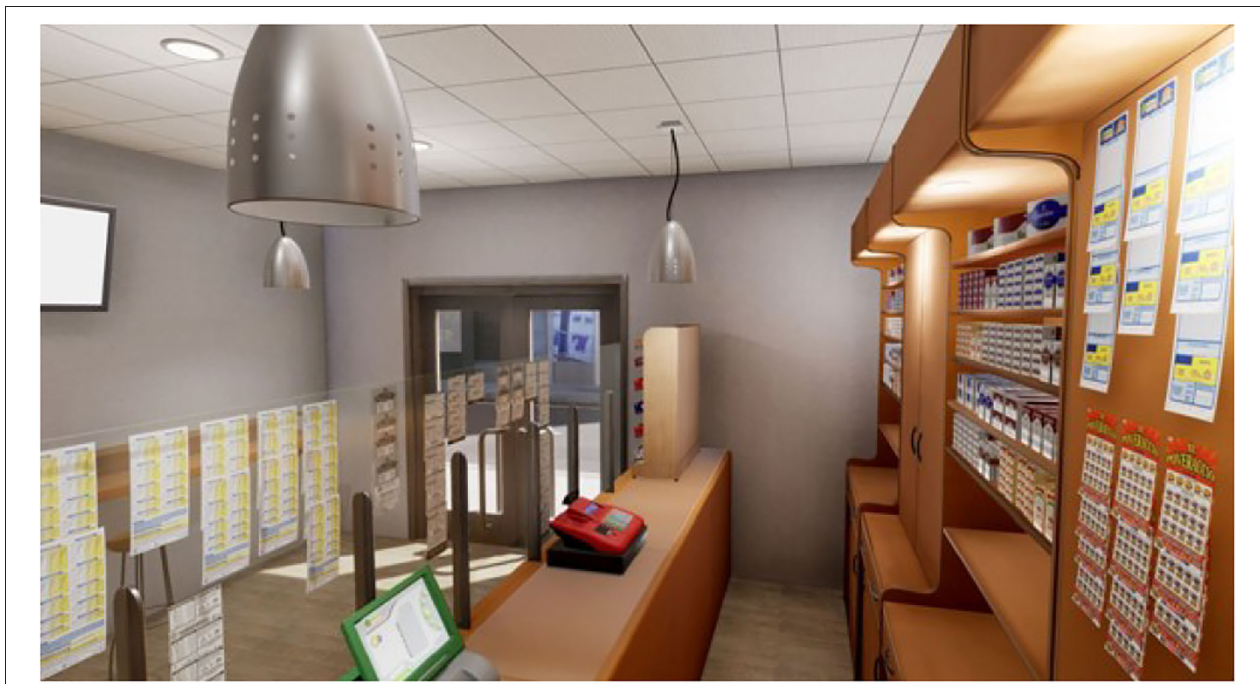
FIGURE 3 | A tobacco store.